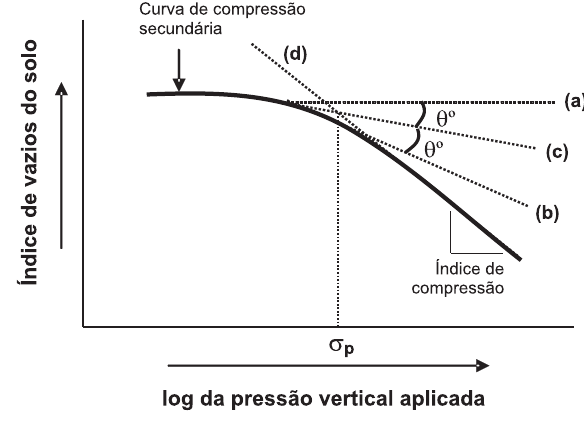
Figura 2. Curva de compressão do solo e estimativa da pressão de preconsolidação ( σσσσσ ) segundo o p método de Casagrande (1936): (a) reta paralela ao eixo das abscissas no ponto de máxima curvatura; (b) reta tangente no ponto de máxima curvatura; (c) bissetriz do ângulo formado entre as retas (a) e (b); (d) reta de compressão